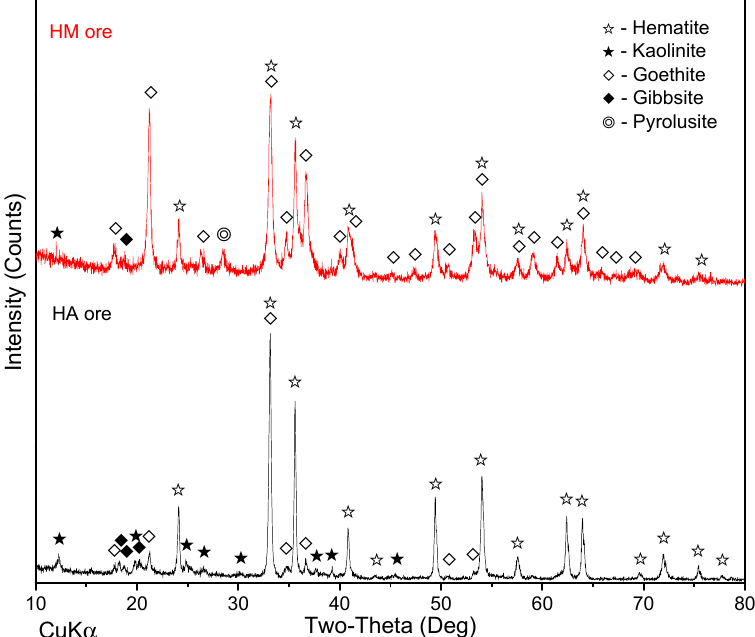
Figure 1. X-ray diffraction (XRD) pattern of high-aluminum iron ore (HA ore) and high-maganese iron ore (HM ore).